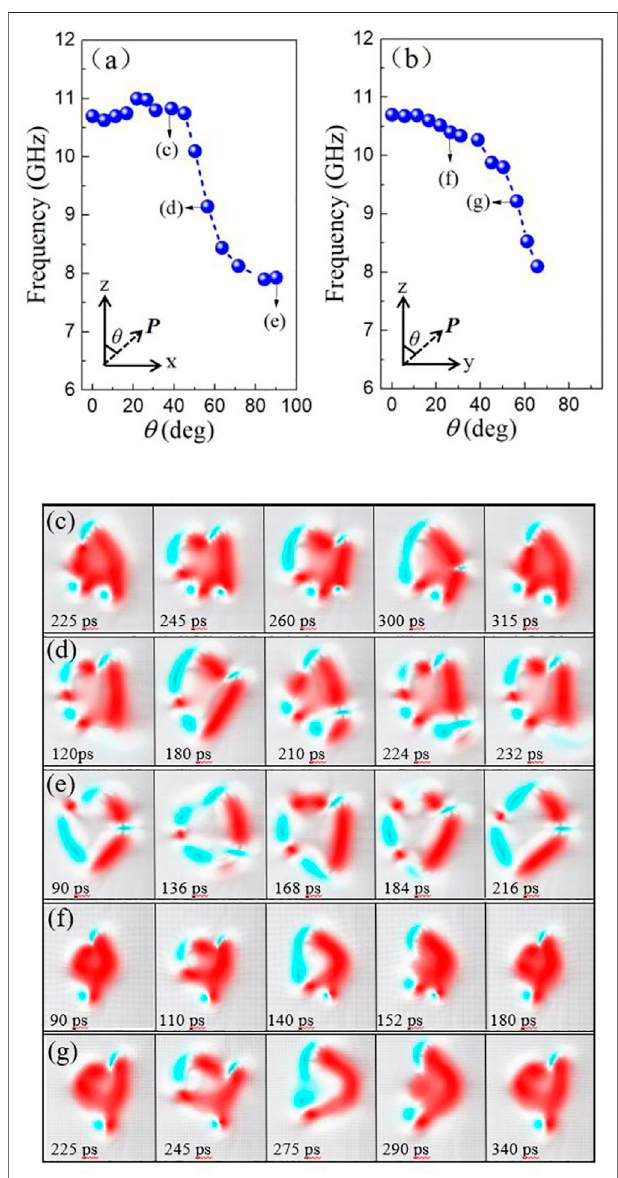
FIGURE 5 | (Color online.) (A,B) Dependence on the oscillation frequency of the angle θ between the positive z axis and polarization direction in x - z plane and in y - z plane. The current density is fi xed to 36 × 10 11 A/m 2 . (C – G) The time evolution of the magnetization m z for different oscillation modes corresponding to different frequencies marked in (A,B)